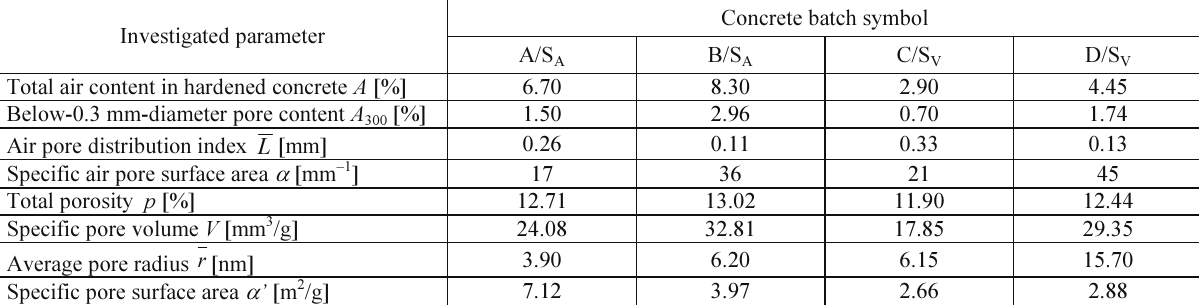
Table 3. Averaged values of selected parameters characterizing pore structure of compared concretes A/S A and C/S V and B/S A and D/S V